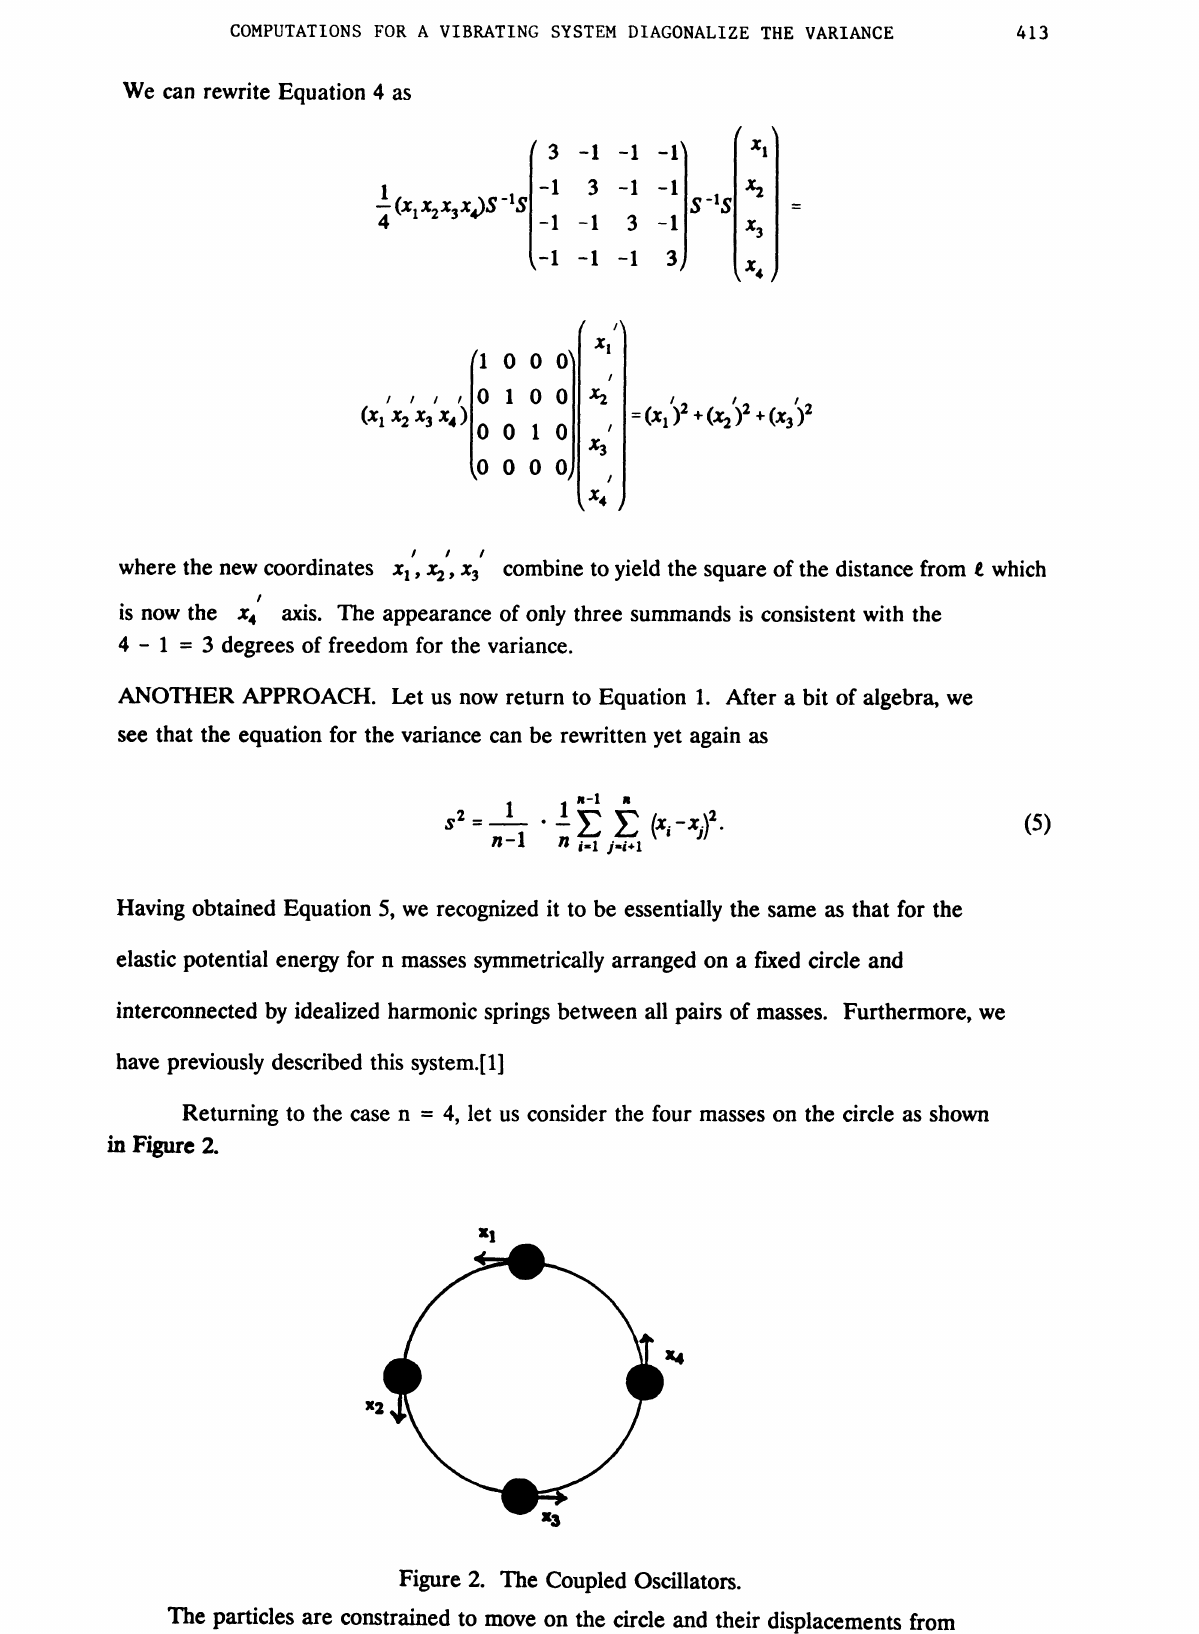
Figure 2. The Coupled